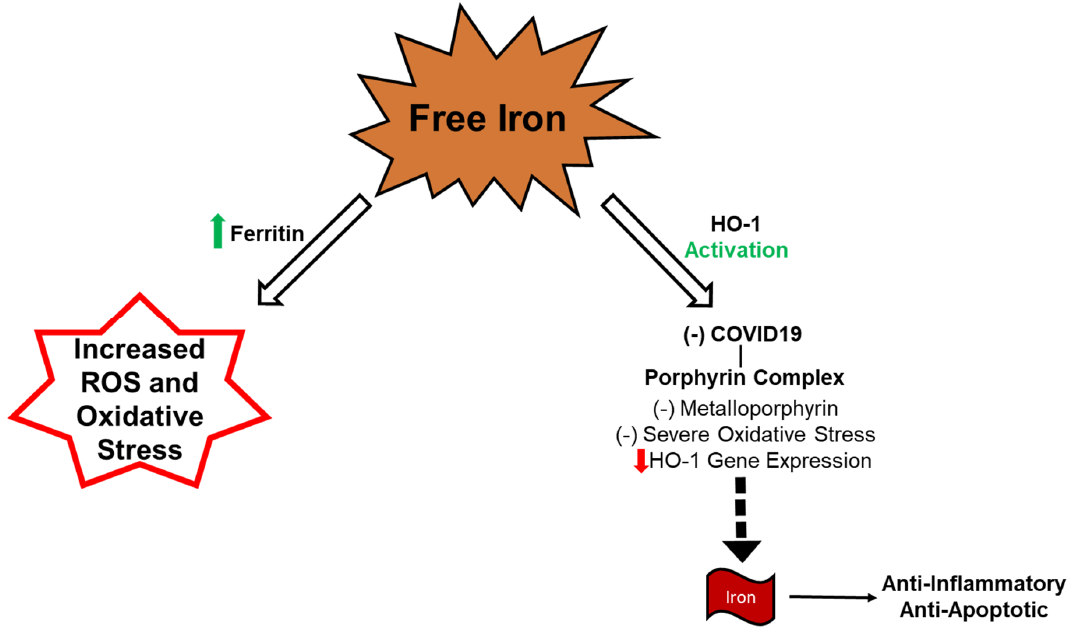
Figure 2. Free iron due to COVID-Porphyrin Complex increases ROS and oxidative stress. 1.4. White Adipocyte vs Brown Adipocyte: Negative Implications in COVID-19